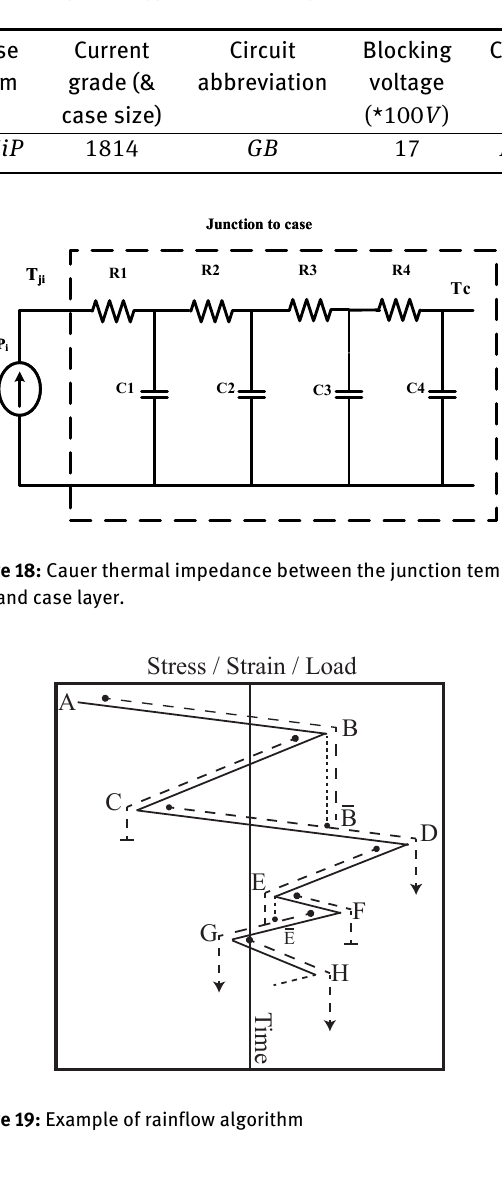
Table 4: Component (type) Designation System.